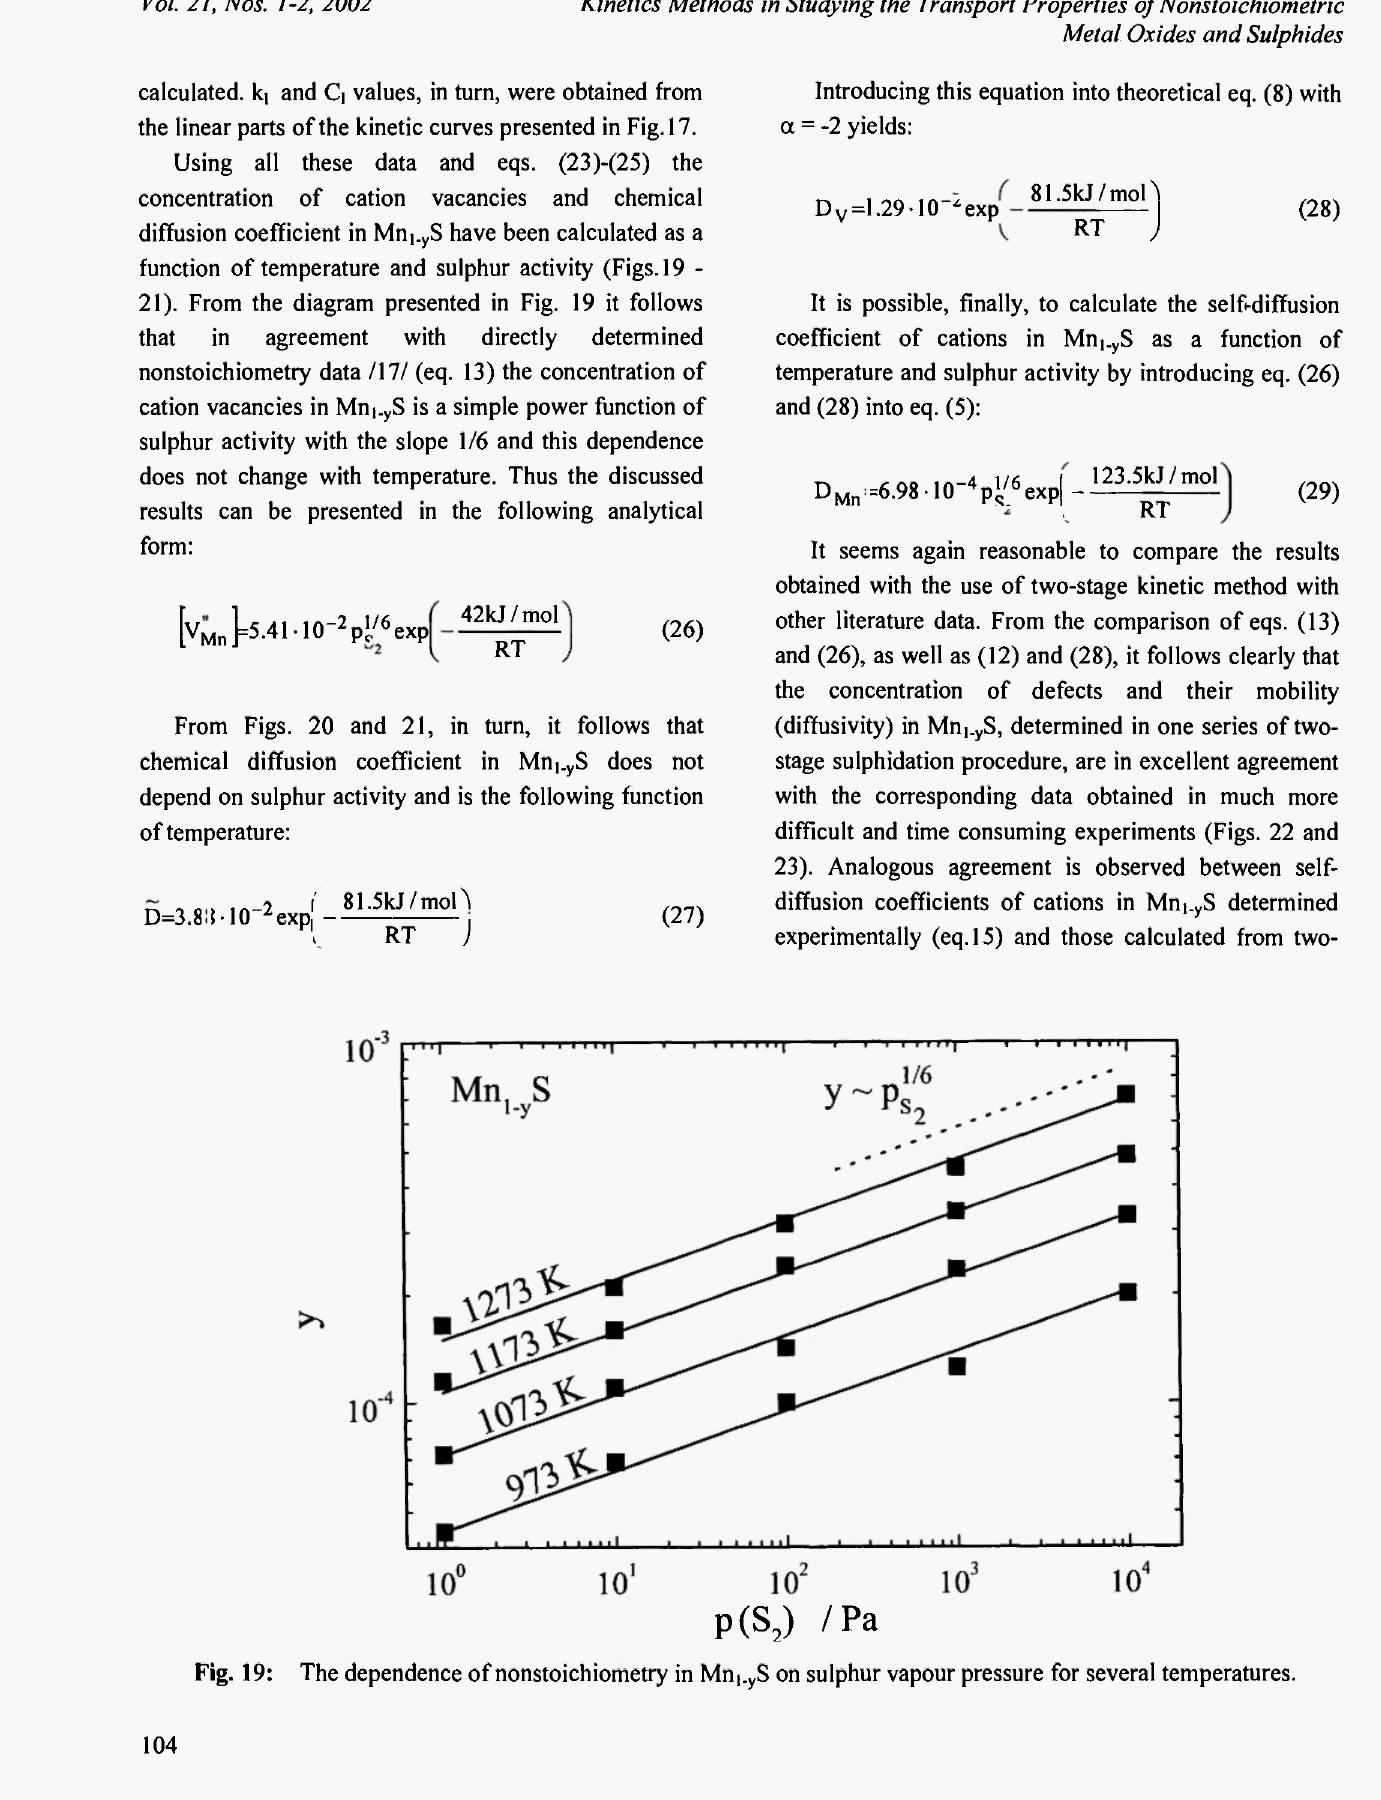
The dependence of nonstoichiometry in Mni. y S on sulphur vapour pressure for several